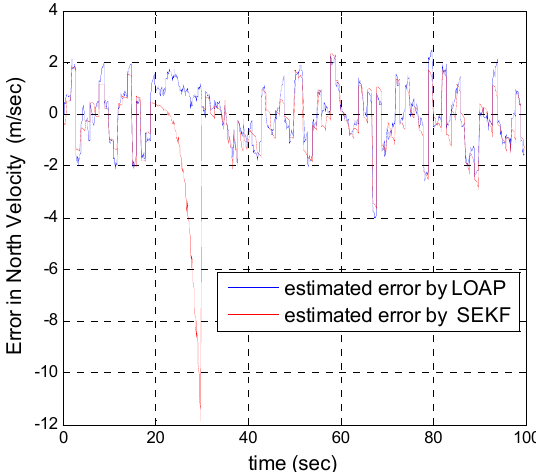
Figure 13. Error estimation of north velocity.